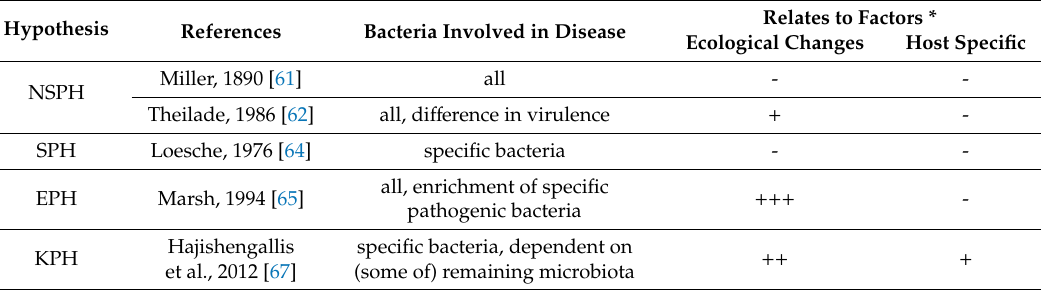
Table 3. Comparison of the di ff erent hypotheses